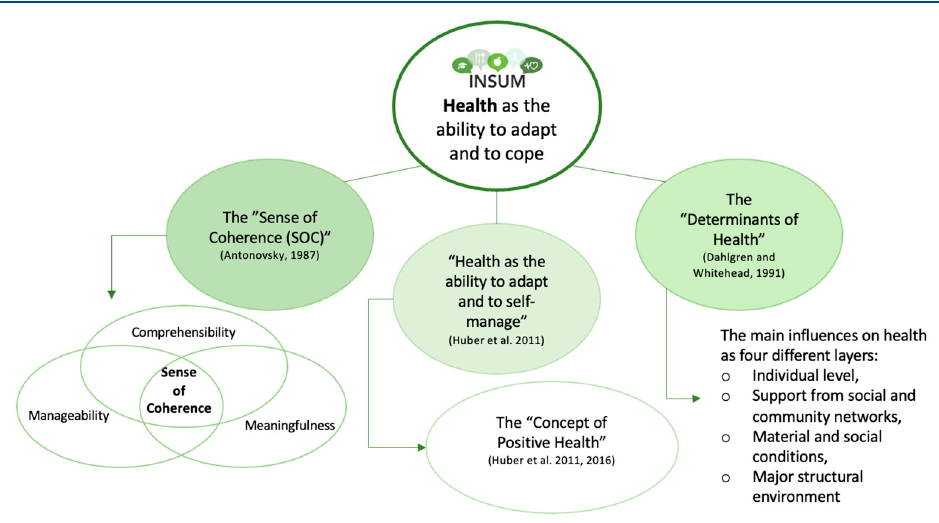
Figure 1. Current understanding of health within INSUM (in green) with the main influencing alternative health approaches [17,25,26]. The understanding of health within the project “Indicators for assessment of health effects of consumption of sustainable, organic school meals in Ecoregions” (INSUM) is built upon Aaron Antonovsky’s “Sense of Coherence” [26] (SOC), the “Determinants of Health” [25] and the “Concept of Positive Health” [19,20]. This current health approach may be further developed within INSUM’s progress (INSUM workshop 1 May 2022). Source: Authors’ own